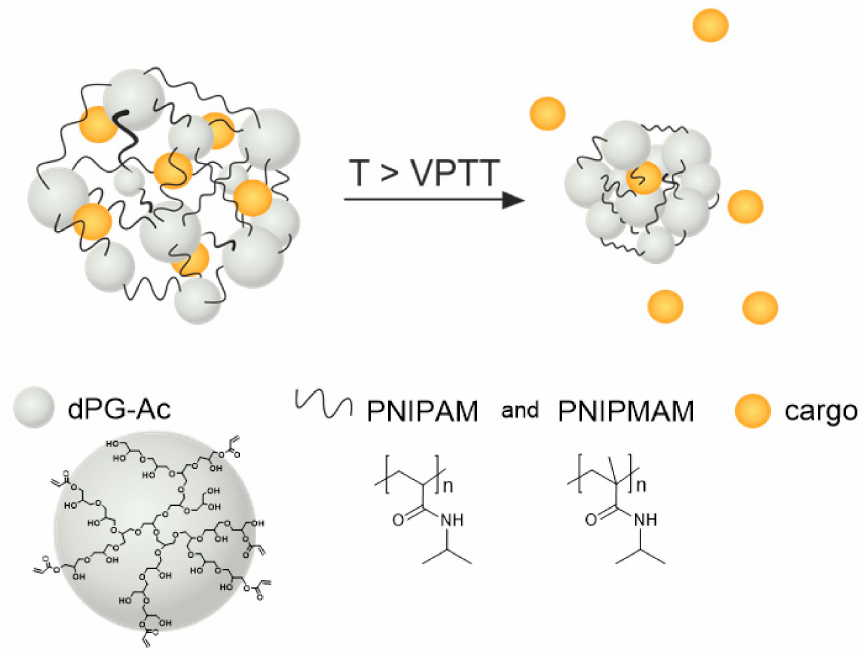
Figure 8. Structure of the thermoresponsive nanogel: linear temperature-sensitive polymers based on poly(N-isopropylacrylamide) (PNIPAM) and poly(N-isopropyl methacrylamide) (PNIPMAM) are crosslinked by acrylated dendritic polyglycerol (dPG-Ac). When the surrounding temperature is higher than the volume phase transition temperature (VPTT) of the thermoresponsive nanogels, they shrink and release the encapsulated